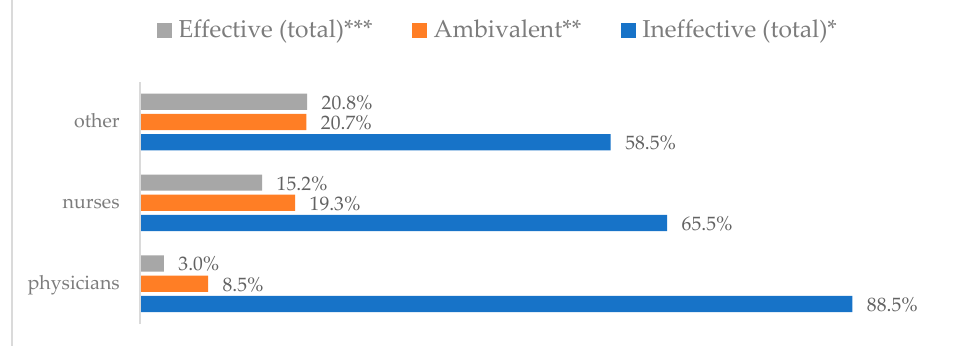
Figure 29. Taking preparations with inosine to prevent influenza virus infection by profession ( N = 905). *Sum of responses: completely ineffective, ineffective, rather ineffective; **Response: neither ineffective nor effective; ***Sum of responses: rather effective, effective, completely effective.